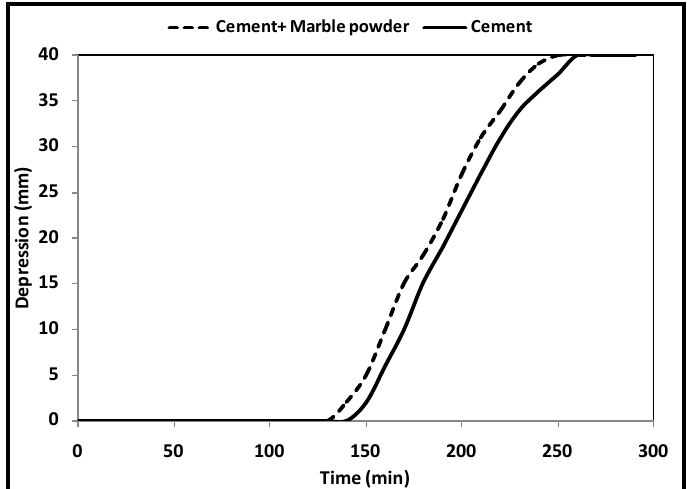
Figure 7. Setting times of cement paste and marble powder–cement paste.